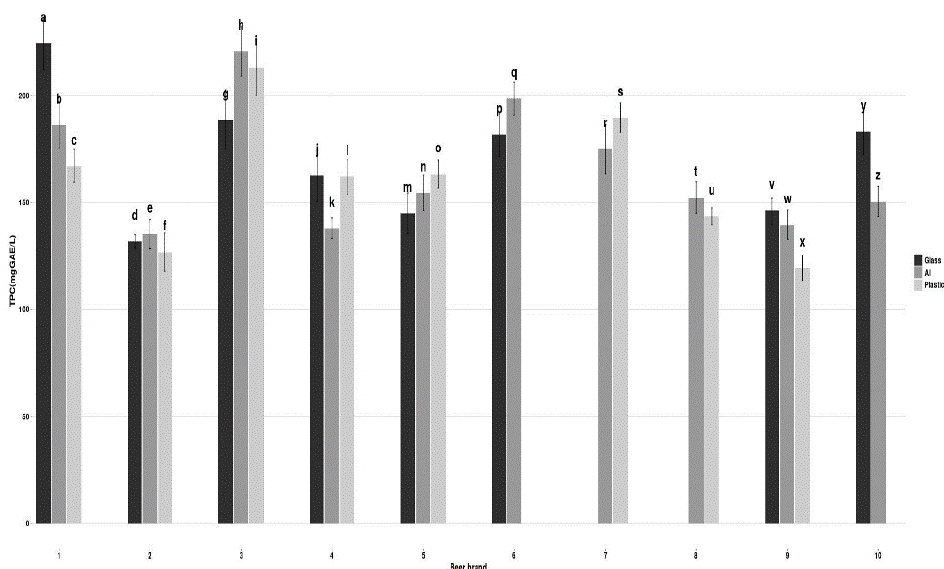
Figure 1. Total phenolic content (mg GAE/L) for 10 ten beer brand and for three packing materials: glass, aluminium and plastic. Vertical bars above each column represent the standard deviation of triplicate determinations. Different letters indicate differences ( p < 0.05) between the samples.